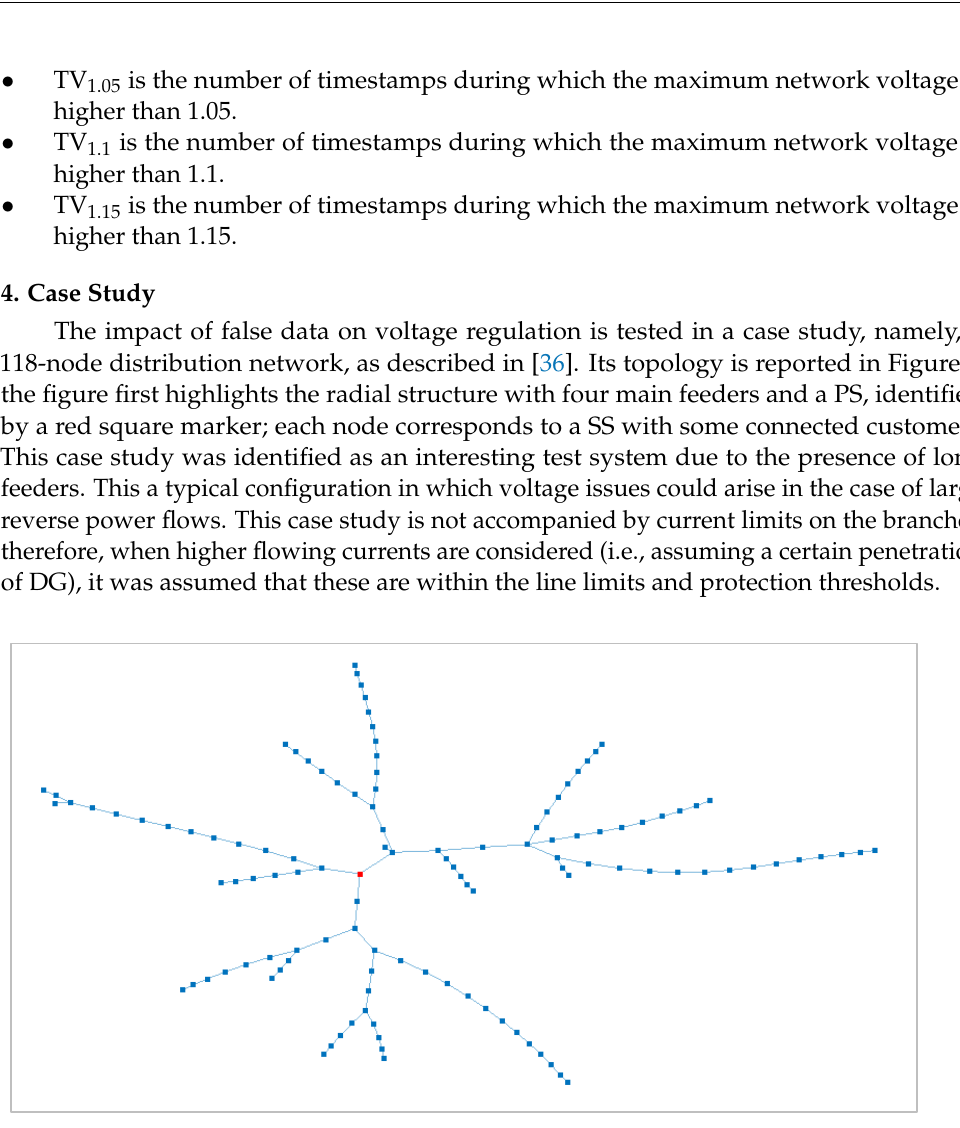
Figure 5. Case study topology (red marker corresponds to the PS).